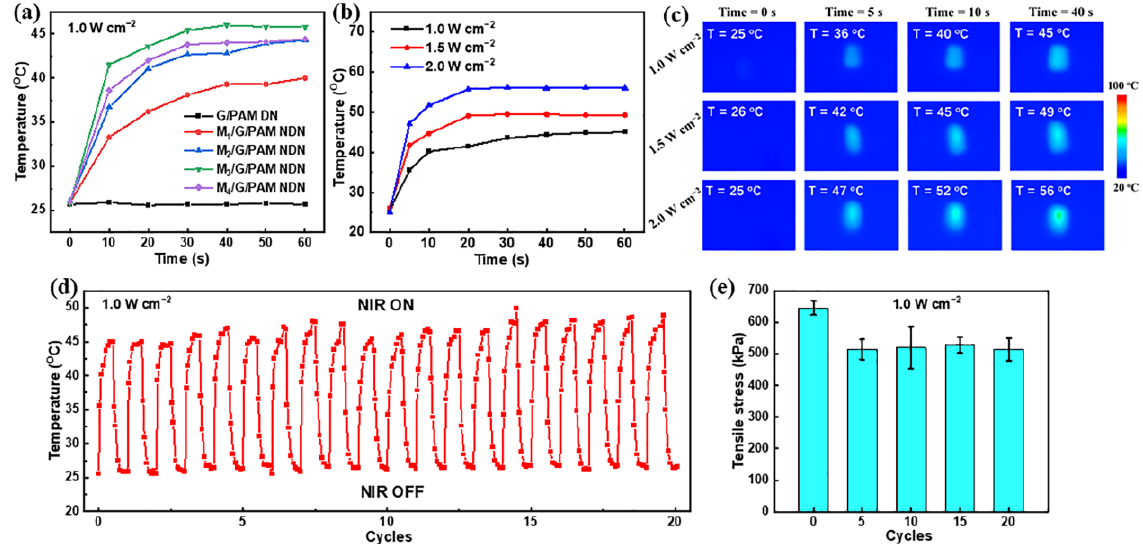
Figure 6. ( a ) Temperature of hydrogels with different Ti 3 C 2 T x contents upon 808 nm NIR laser irradiation (1.0 W cm − 2 ); ( b ) the temperature rise curves and ( c ) real-time infrared thermal images of M 3 /G/PAM NDN hydrogel under 808 nm NIR laser irradiation with different power densities (1.0, 1.5, and 2.0 W cm − 2 ); stability of M 3 /G/PAM NDN hydrogel: ( d ) 20 cycles photothermal stability under repeated laser on–off of 808 nm NIR laser irradiation (1.0 W cm − 2 ); ( e ) tensile strength under repeated laser on–off of 808 nm NIR laser irradiation (1.0 W cm − 2 ) (5 cycles, 10 cycles, 15 cycles, and